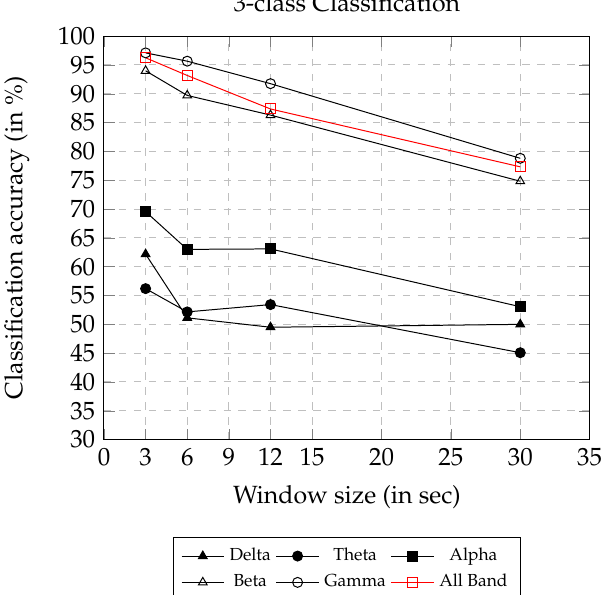
Figure 4. 3-class classification accuracy on varying window size using AsMap+CNN